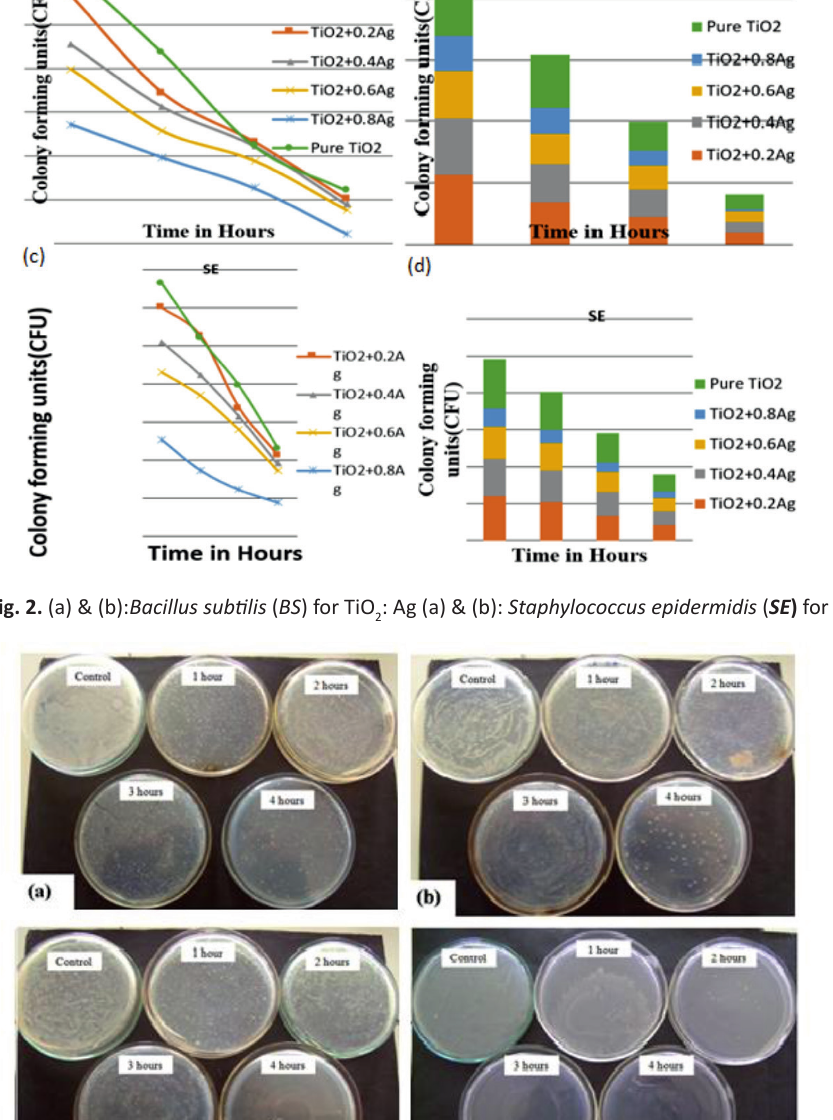
+Ag at Different Concentrations on Staphylococcus aureus a) 0.2% Ag; b) 0.4% Fig. 3. Antibacterial Images of TiO 2 Ag c) 0.6% Ag; d) 0.8%